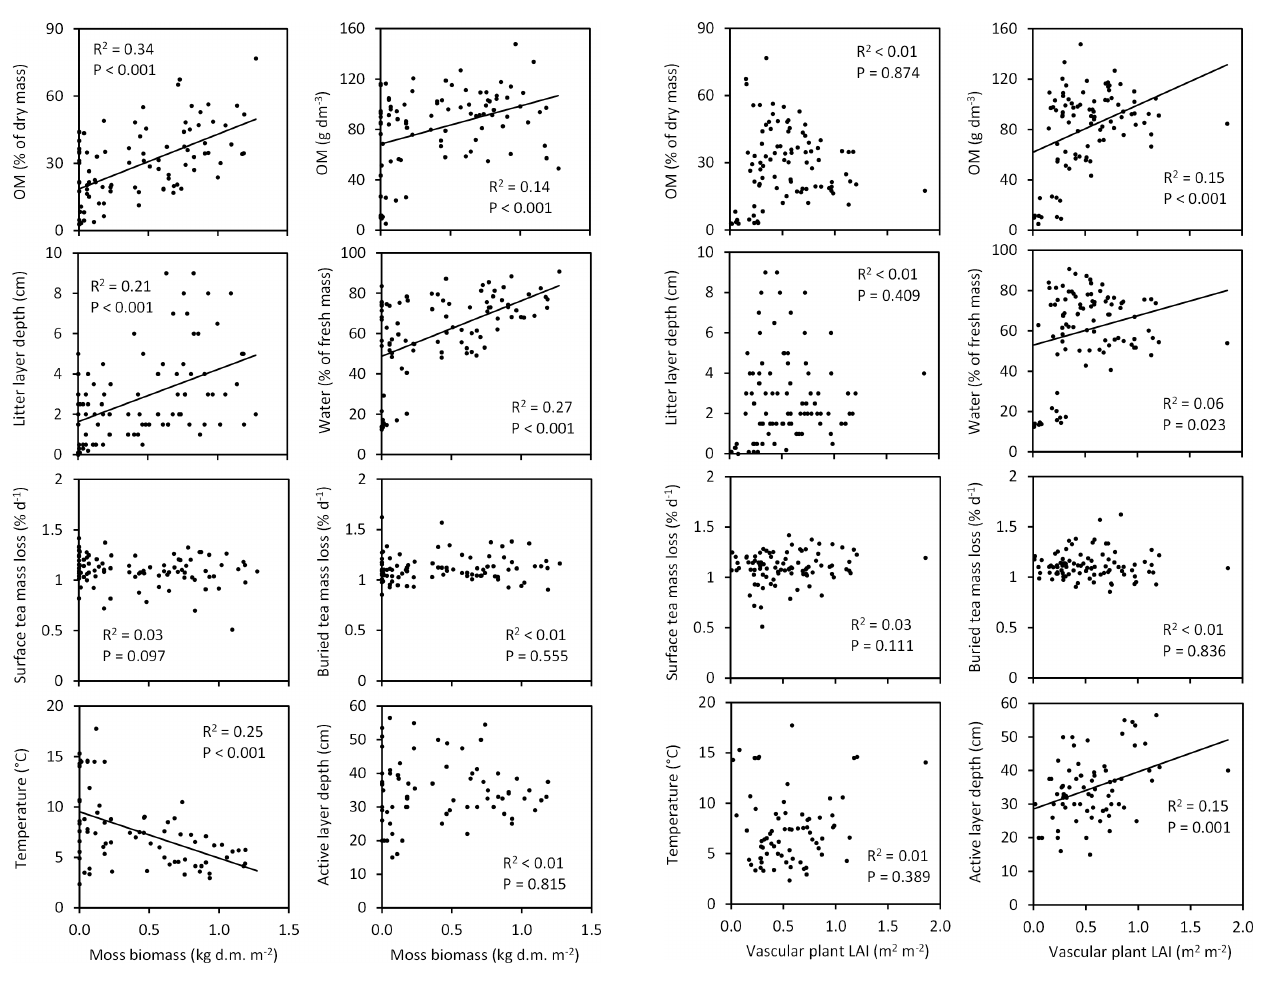
Figure 10. Associations of moss biomass with soil characteristics across the Tiksi tundra field plots. R 2 and P values are from lin- ear regression analyses with lines shown for statistically significant associations only; n = 92 except for temperature and active layer depth, where n = 73. Soil organic matter percentage (OM%), OM content and moisture are for the top 10cm soil layer. The litter layer consists of both vascular and moss plant material. Teabags were buried and temperature measured at a depth of 5 and 15cm, respec- tively. Temperature and active layer depth measurements represent week 31 and 33, respectively.